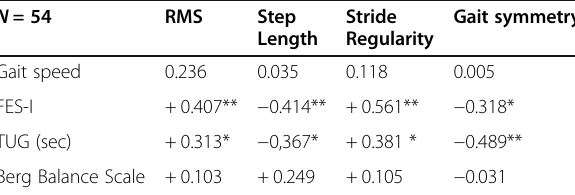
Table 4 Correlations of accelerometer-derived data in the anteroposterior plane with FES-I and performance tests N =